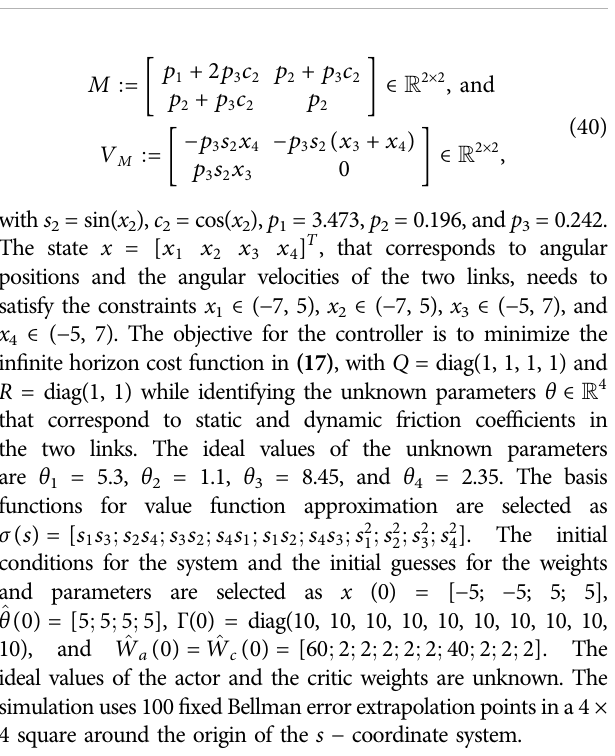
TABLE 1 | Comparison of costs for a single barrier transformed trajectory of (35) , obtained using the optimal feedback controller generated via the developed method, and obtained using pseudospectral numerical optimal control software.